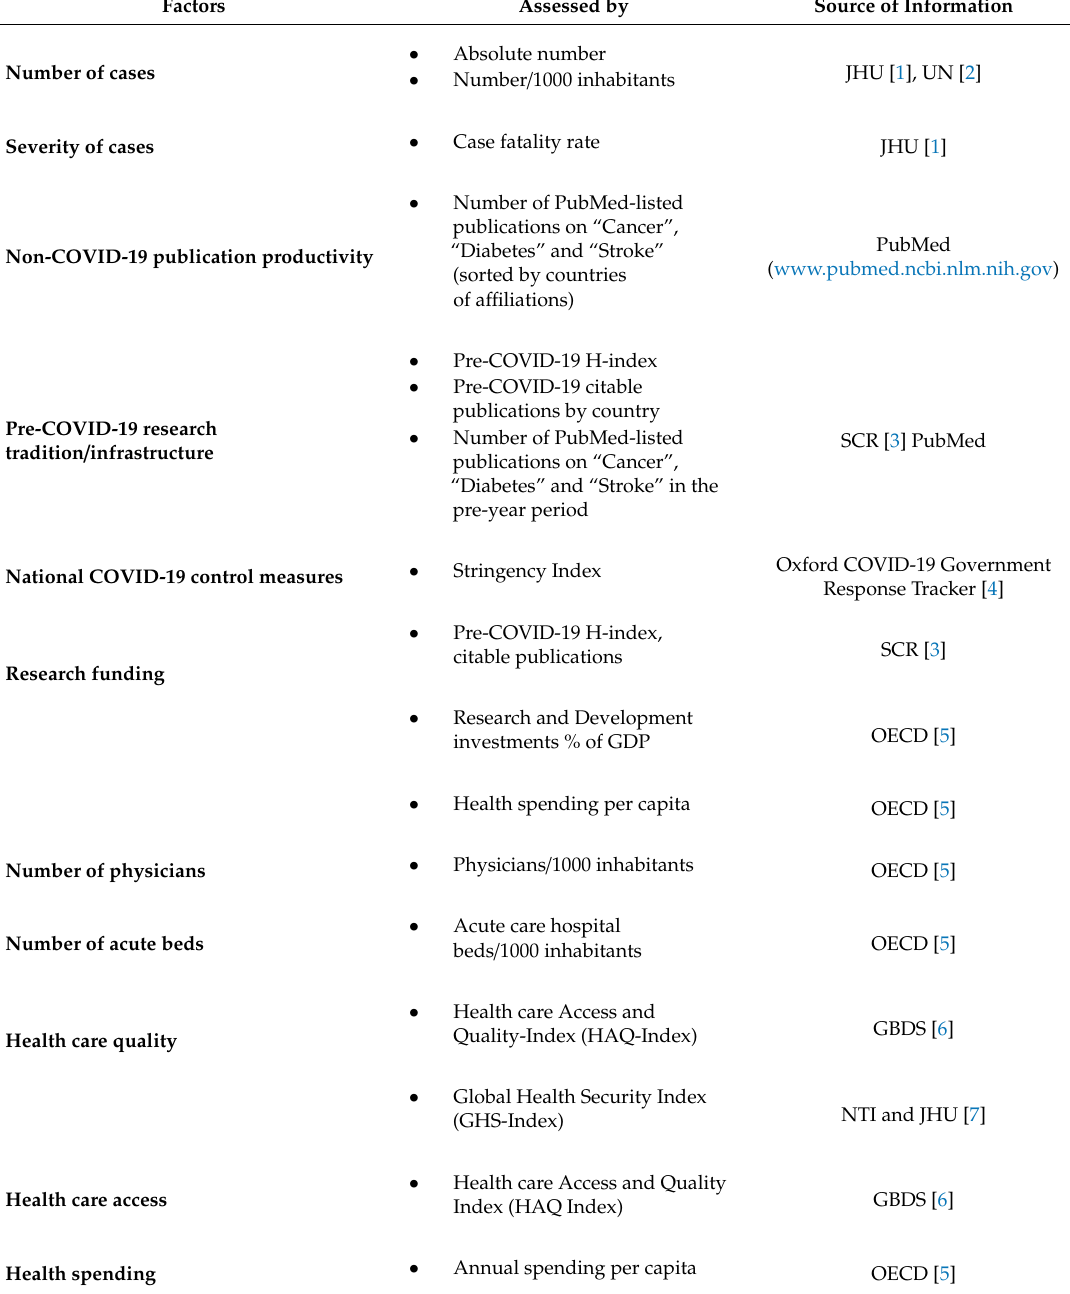
Table 1. National factors potentially influencing COVID-19-related publication